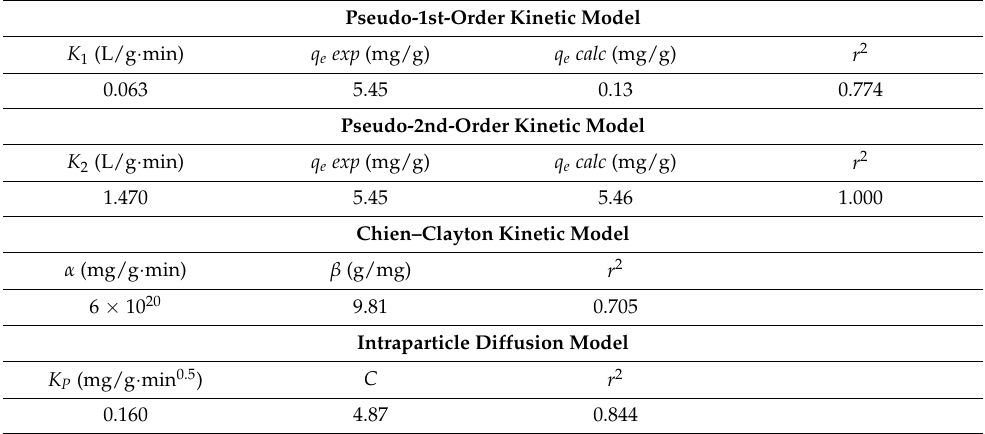
Figure 4. Variation of the lactic acid concentration on the A100 resin phase as a function of the contact time (1 g/L of lactic acid, resin/lactic acid ratio of 0.15 g/mL, pH 4). Table 6. Comparison of kinetic parameters for pseudo-first-order, pseudo-second-order, Chien– Clayton and intraparticle diffusion kinetic